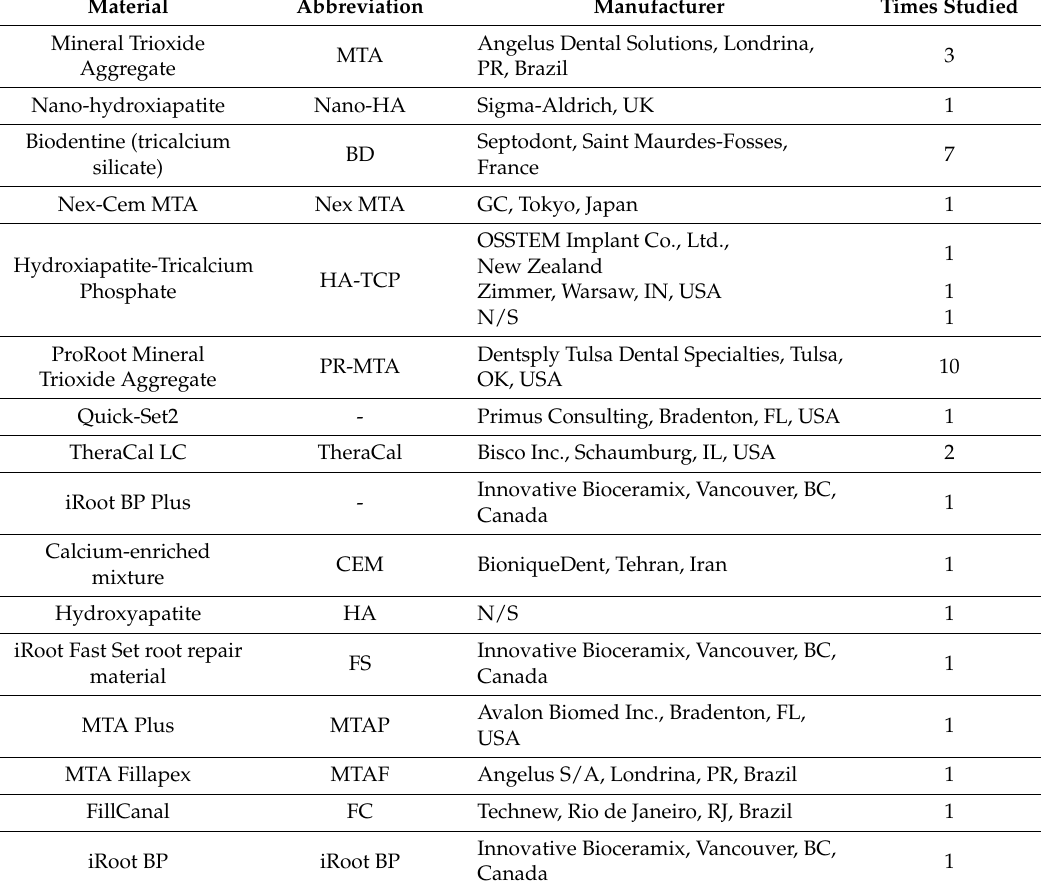
Table 2. List of commercially available bioceramic materials